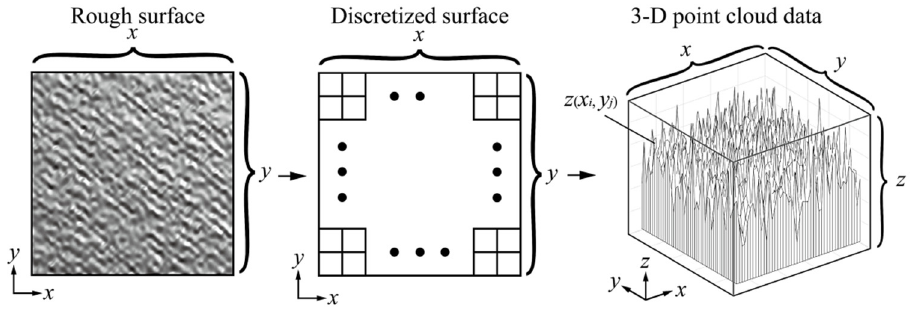
Figure 3. Digital image conversion of rough surfaces.